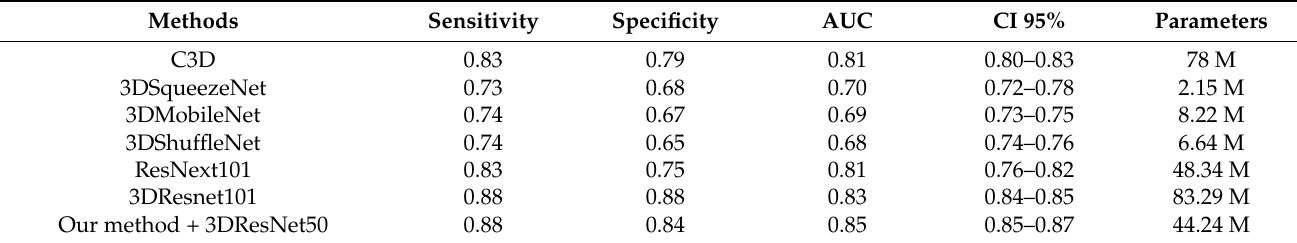
Table 1. Comparison with 3D-CNN methodologies.